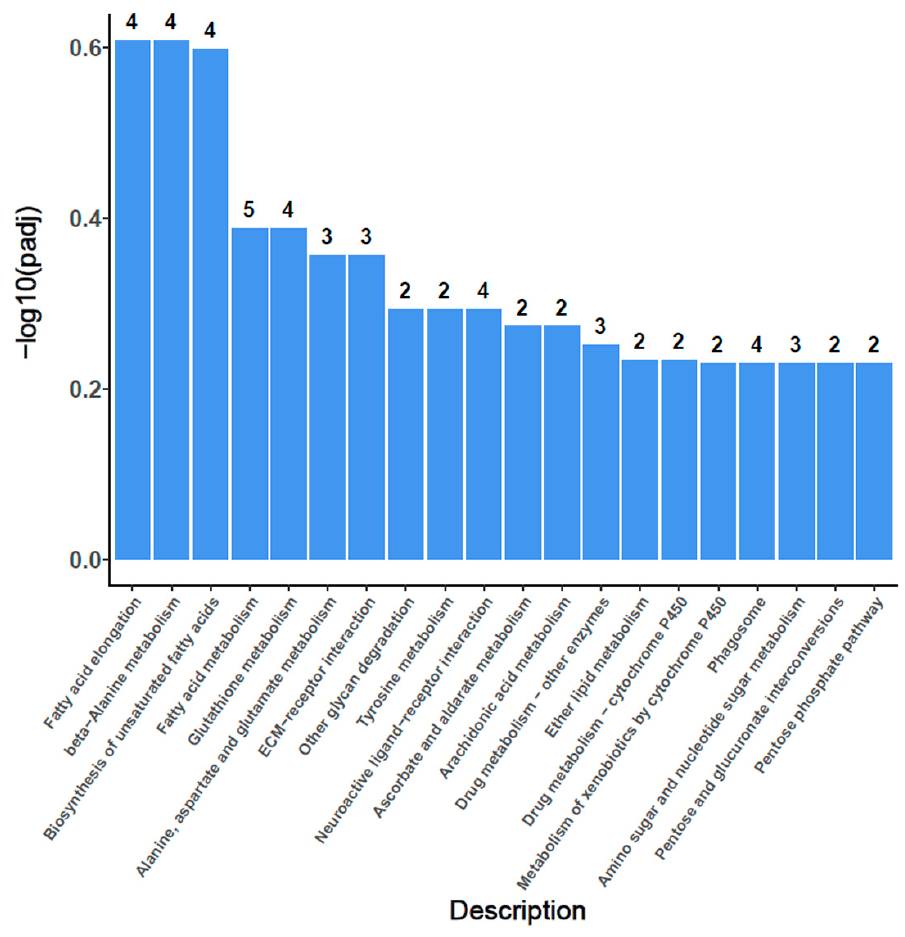
Figure 6. KEGG pathways of the differentially expressed unigenes in honeybee larvae from the EMF group and CK group. KEGG pathways enrichment showed that ELF-EMF exposure mainly decreased the activity of nutrient and energy metabolism honeybee larvae.